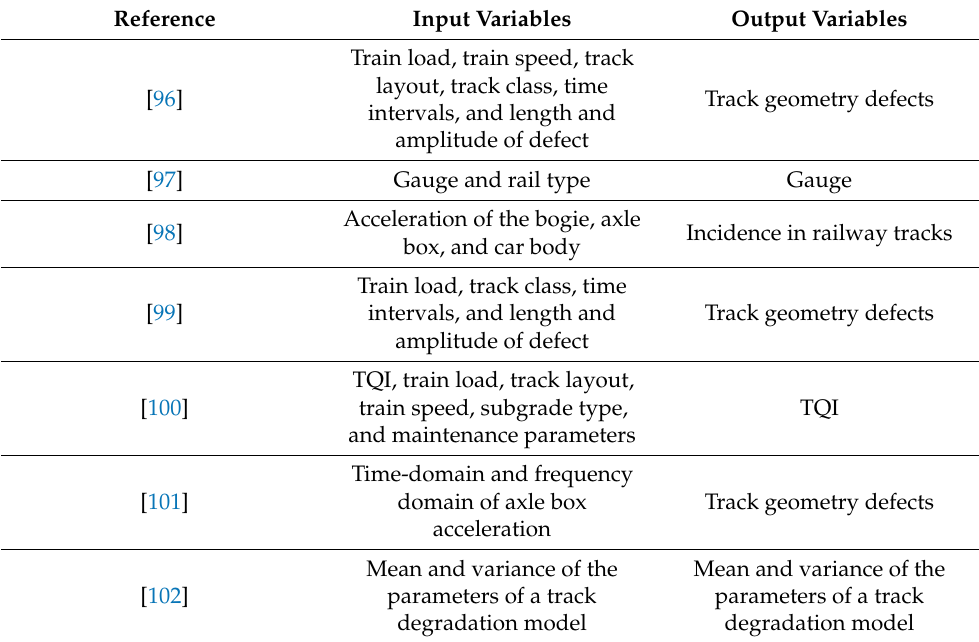
Table 9. Input and output variables in existing prediction modes based on